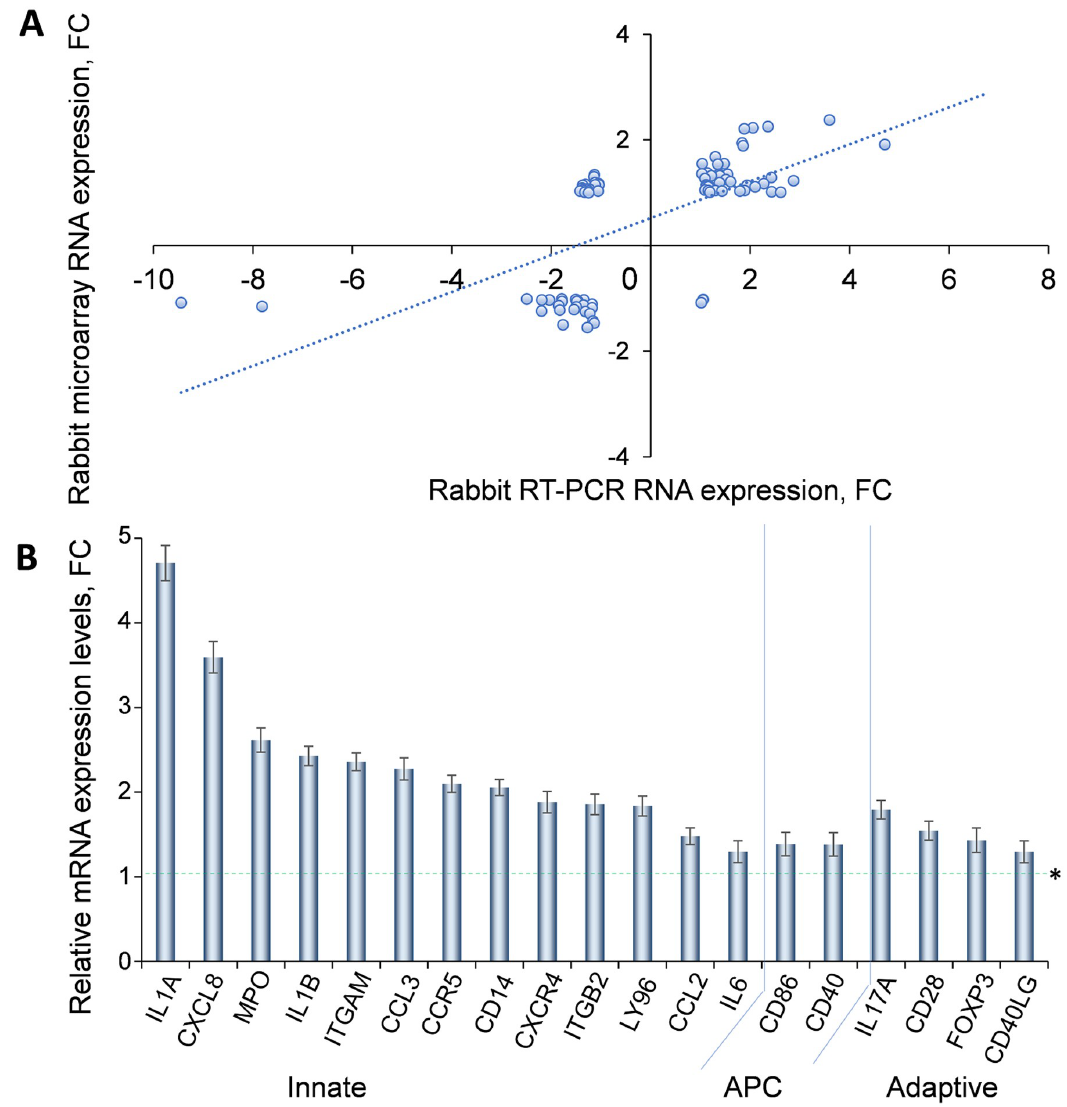
Fig 5. RT-PCR analysis of immune response genes. A . Correlation of RNA expression levels of inflammatory mediators in DED rabbits obtained with both: RT-PCR and microarray methods. (PCC R = 0.622, n = 84, p-value < 0.001.) B. The relative expression (RT-PCR) of 18 selected genes representing innate, transition (APC, antigen presenting cells) and adaptive immunity. Each bar represents mean ± SD of fold change (n = 8, � p < 0.001) in DED compared to normal mRNA levels, normalized to the 5 host genes as in